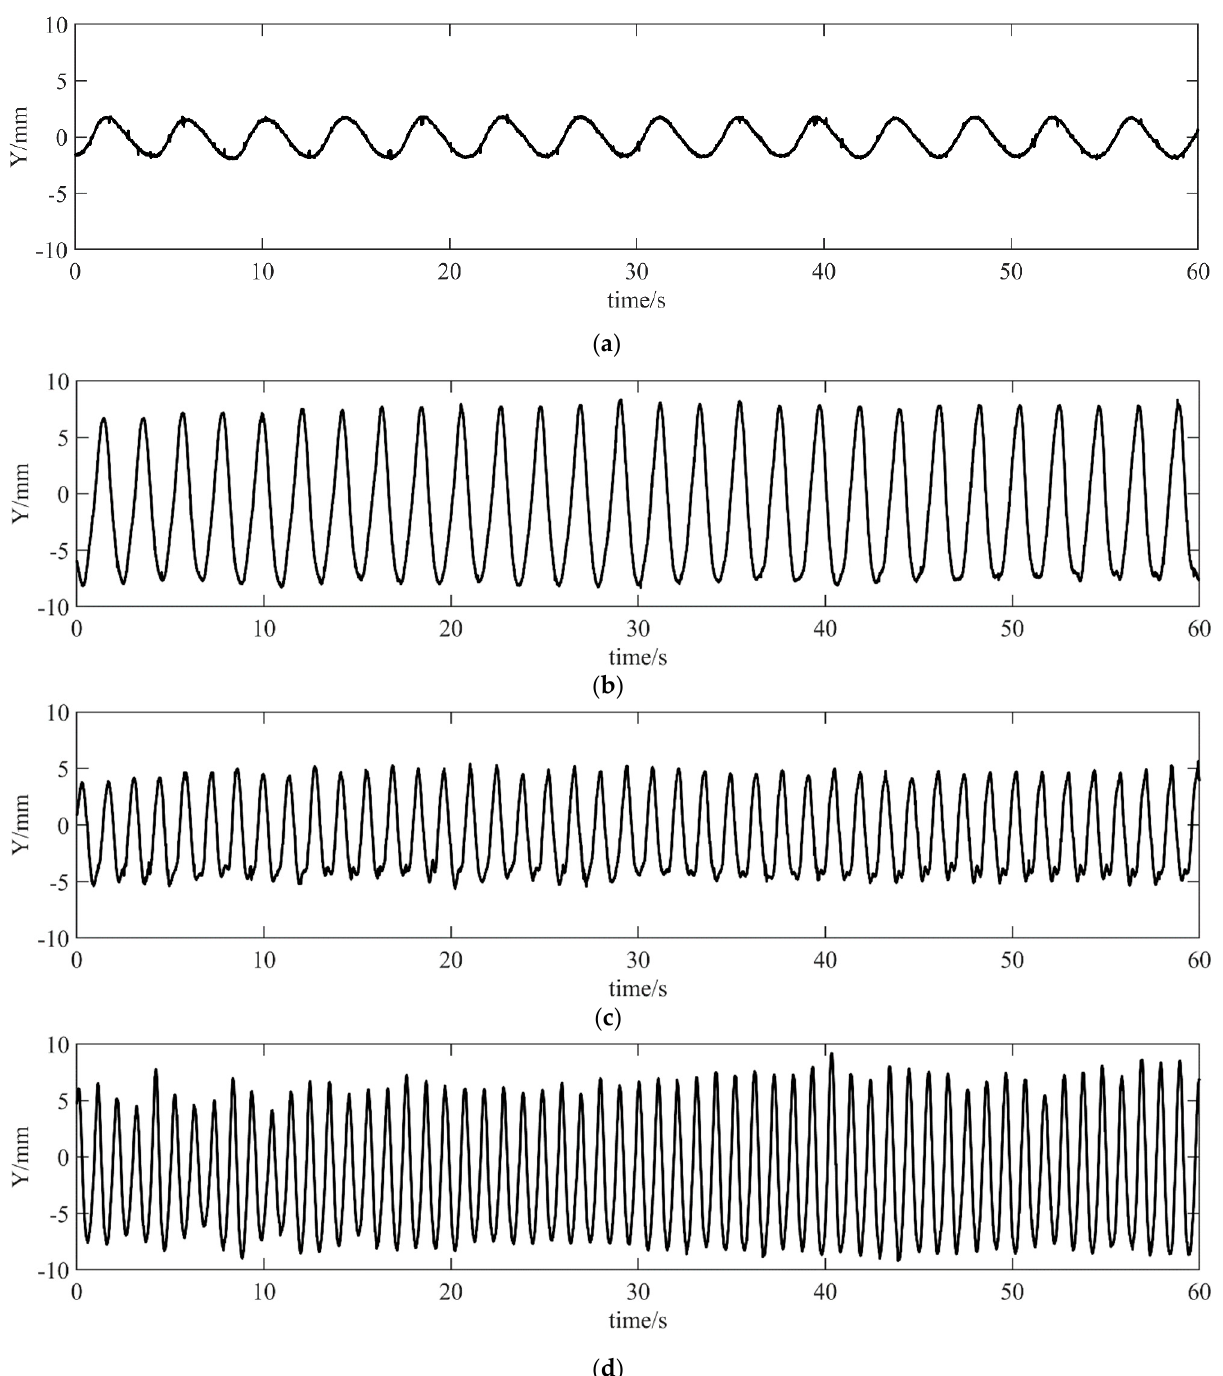
Figure 5. Four group wave surface changes within 60 s collected by Wave sensor. ( a ) Wave case (1); ( b ) Wave case (2); ( c ) Wave case (3); ( d ) Wave case (4).